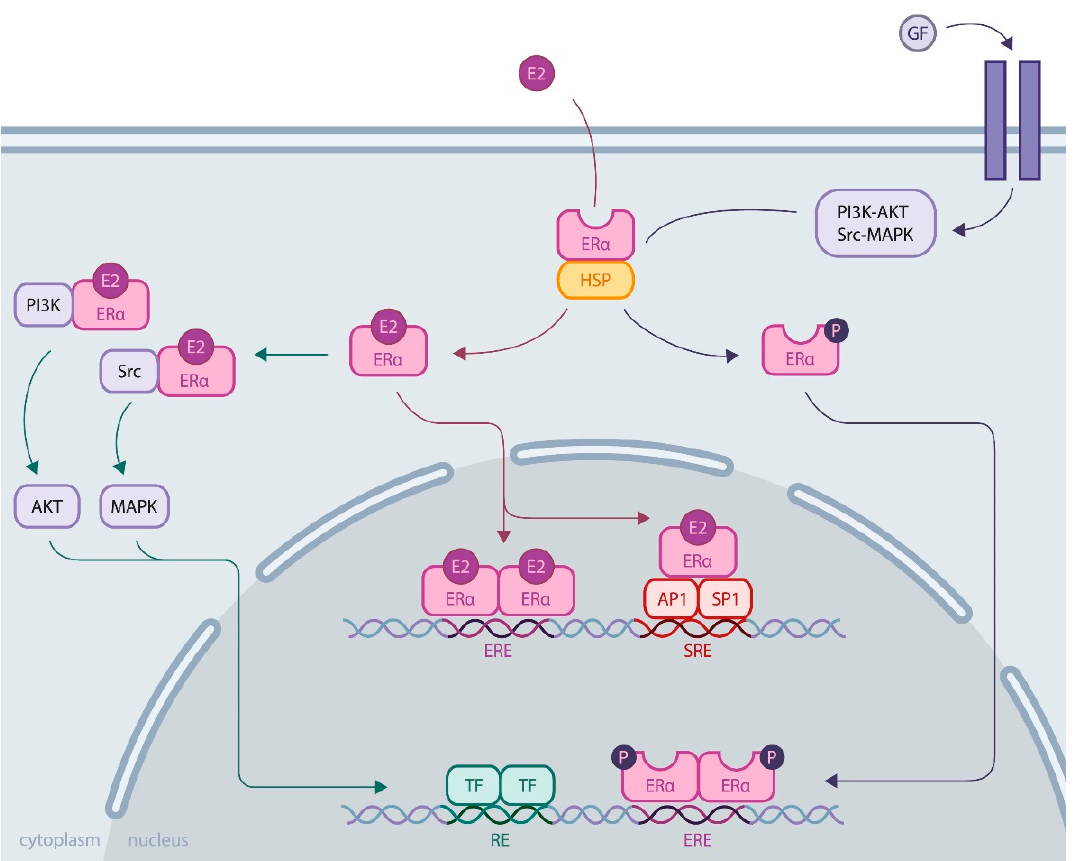
Figure 1. ER α activity through genomic and nongenomic actions. Genomic activity : ER α activation upon estrogen binding (E2) or after its phosphorylation by cellular kinases following growth factor (GF) receptor stimulation allows its release from heat shock proteins (HSPs). Then, ER α translocates into the nucleus, where it binds DNA by direct (through estrogen responsive elements, EREs) or indirect mechanisms (upon binding to other transcription factors, such as AP1 or SP1, that bind DNA through serum responsive elements, SREs). Nongenomic activity : Activated ER α interacts with cellular kinases (e.g., PI3K and Src), leading to signaling pathway stimulation involving AKT or MAPK, for example, eventually resulting in transcription factor (TF) activation. All these mechanisms induce transcriptional activation or repression of the regulation of cell fate.